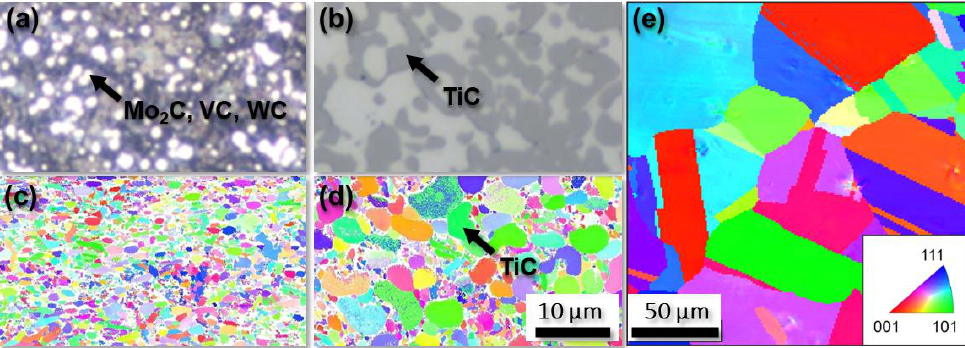
Figure 1. Microstructure including reinforcing phases of Z-M4 ( a , c ), WFN ( b , d ) and AISI 347 ( e ) observed by light optical microscopy ( a , b ) and by EBSD ( c – e ). Table 5. Grain and particle sizes of the investigated materials.